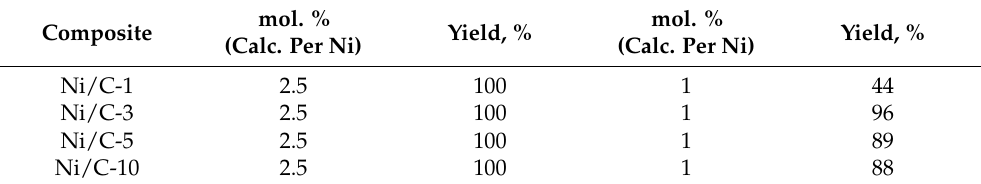
Table 3. Yields of the 1,2,3,4-tetrahydroquinoline at different loadings of the composites. Reaction